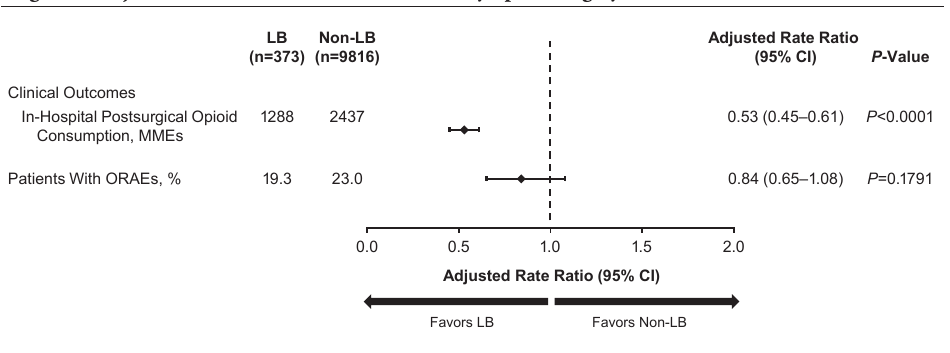
Figure 2. Adjusted Clinical Outcomes After Primary Spine Surgery in Pediatric Patients